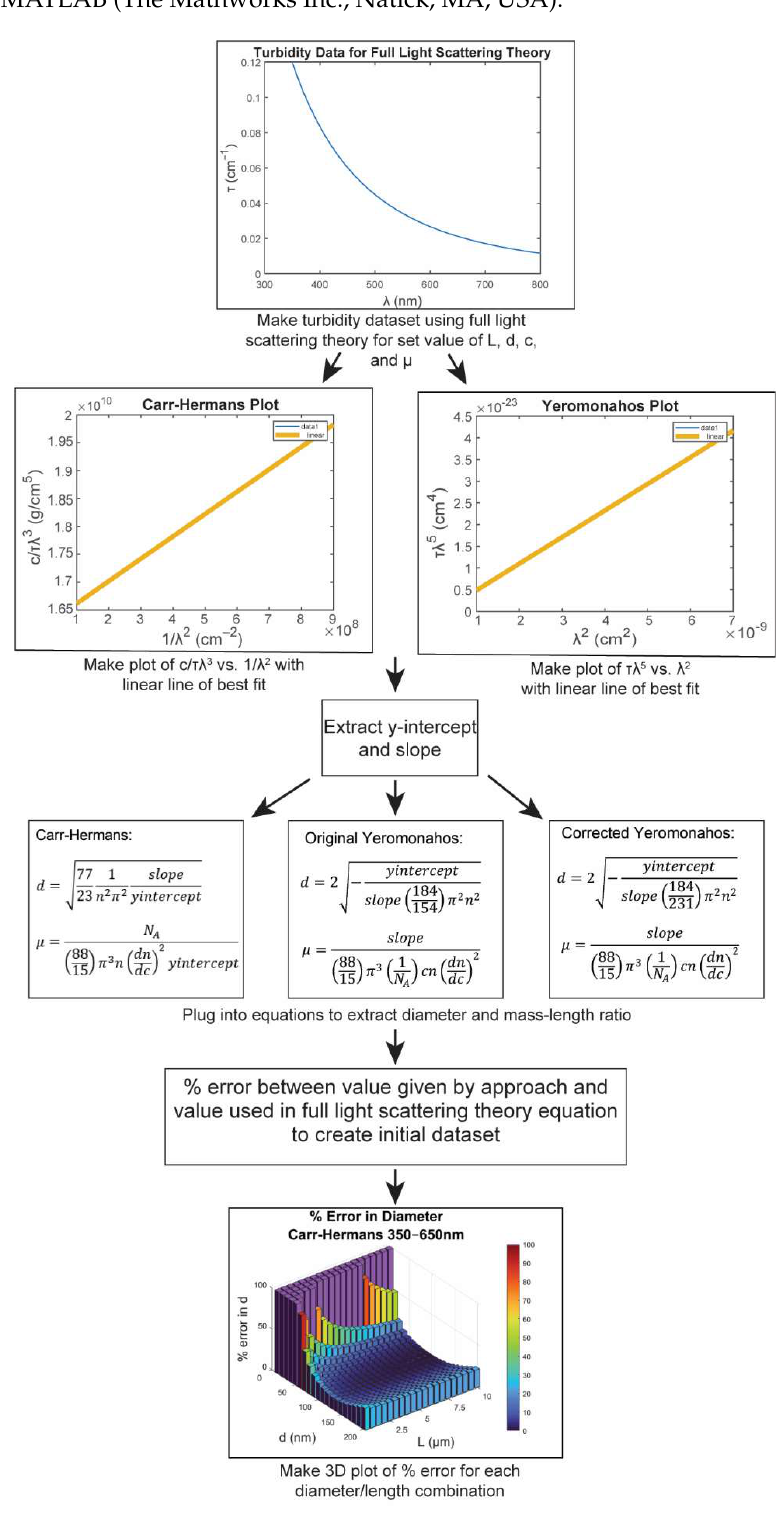
Figure 3. An outline of the methods for determining the percent error in each approach, using con- stant values of n and dn/dc.